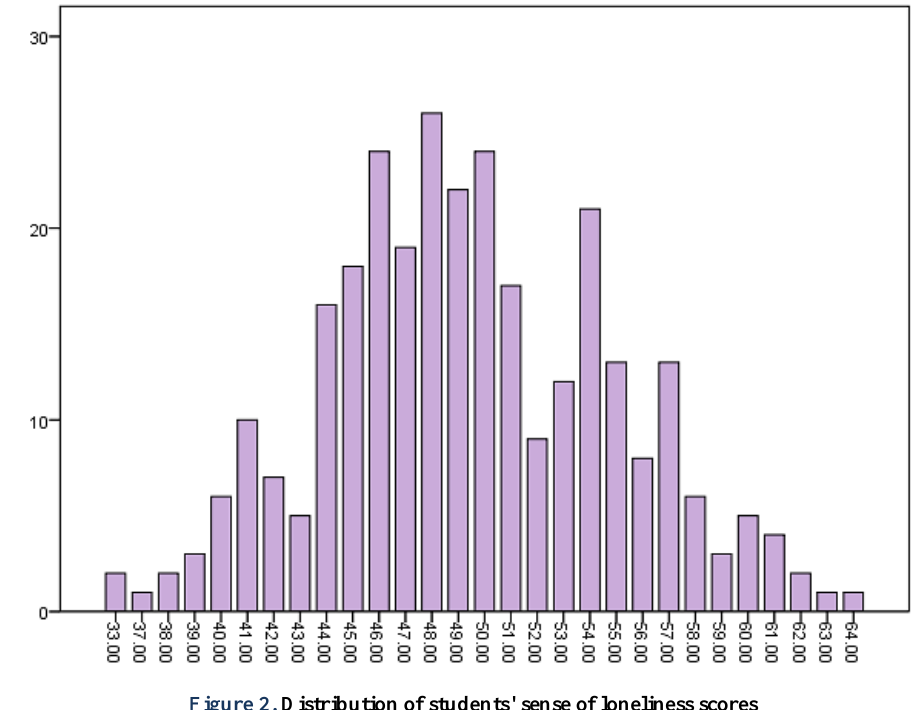
Figure 2. Distribution of students' sense of loneliness scores